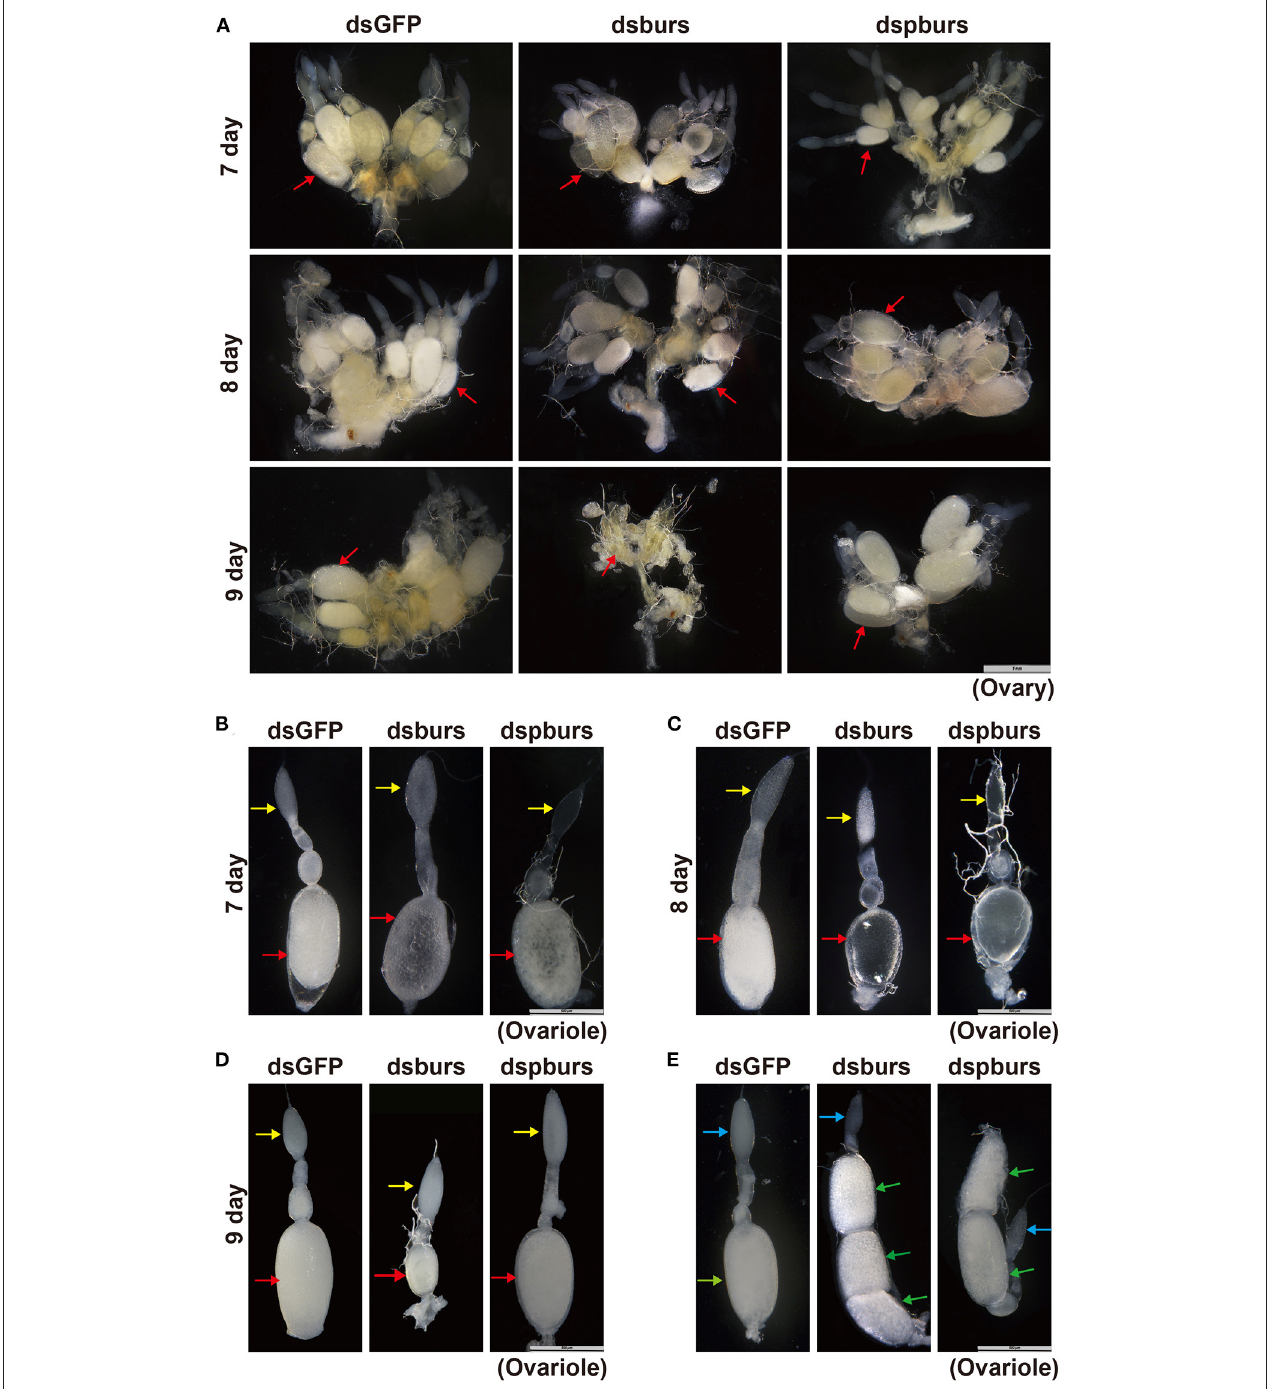
FIGURE 3 | Phenotypes of the ovary and ovariole in burs or pburs RNAi beetles. (A) The ovaries from 7-, 8-, and 9-day females after dsGFP, dsburs, and dspburs treatments. (B–D) The ovarioles from 7-, 8-, and 9-day females after dsGFP, dsburs, and dspburs treatments. (E) The ovarioles from the mated females 7-day post-dsGFP, dsburs, and dspburs treatments. The red arrows indicate oocytes from the unmated females, and the yellow arrows indicate germarium from the unmated females. The green arrows indicate oocytes from the mated females, and the blue arrows indicate germarium from the mated females.